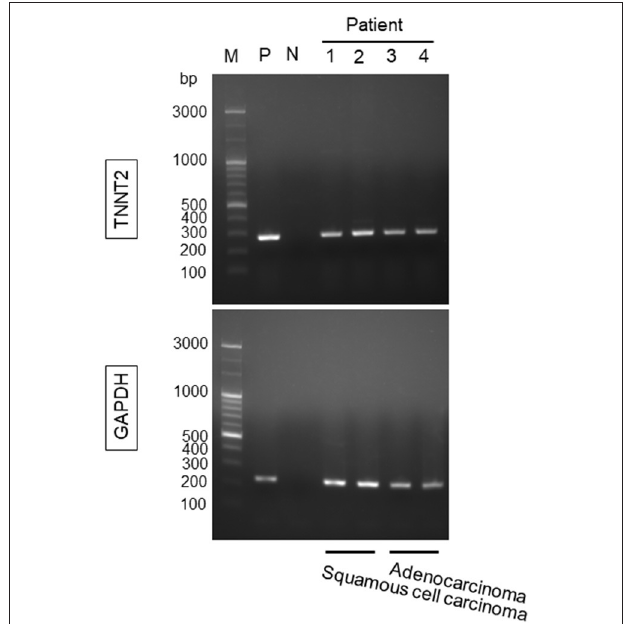
FIGURE 4 | Gene expression for TNNT2 in lung squamous cell carcinoma and adenocarcinoma. Lung cancer tissues were obtained from four patients (2, squamous cell carcinoma; 2, adenocarcinoma) during the rapid intraoperative pathological diagnosis. M, marker; P, positive control (human heart); N, negative control; 1 and 2, lung squamous cell carcinoma; 3 and 4, lung adenocarcinoma. GAPDH was used as a reference